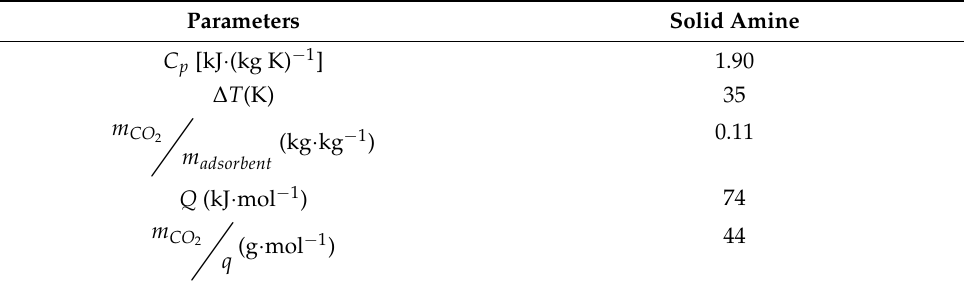
Table 2. The parameters of the parasitic energy model.